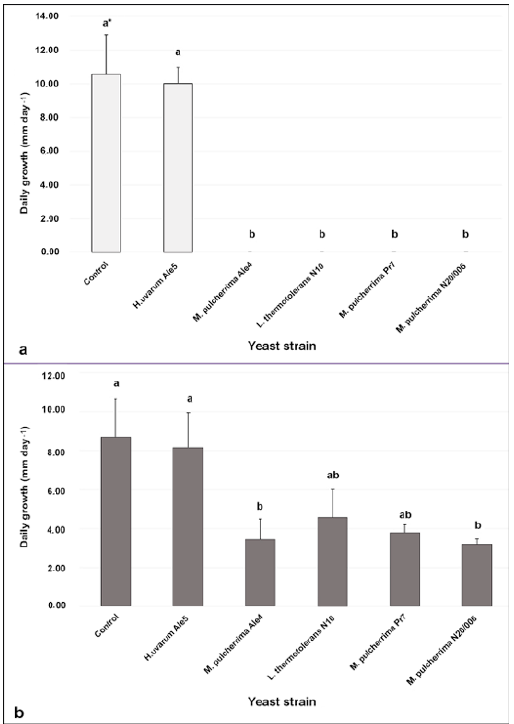
Figure 1. In vitro assays ( a ) cellophane agar layer technique (white bars) (CALt); ( b ) antagonistic activity of volatile organic compounds (VOCs) (grey bars). In vitro antagonistic activity of yeast strains refer to mycelial daily growth of Botrytis cinerea. Data are presented as the mean of five replicates with standard deviation (vertical bars). * Columns labeled by different letters are significantly different according to the Dunn’s test ( p < 0.05).